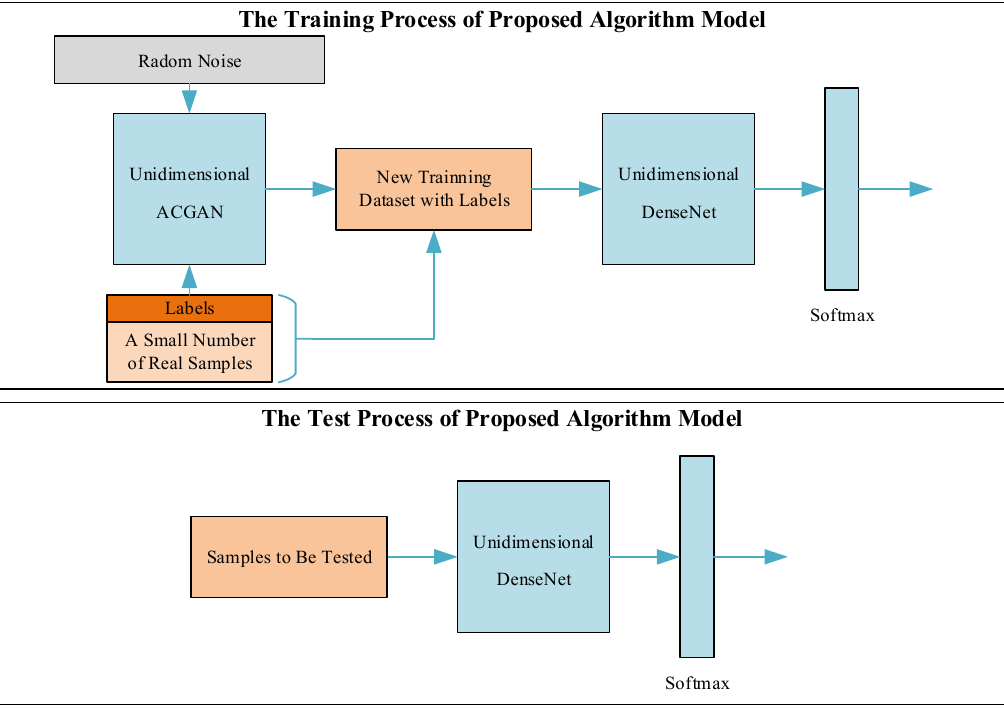
Figure 2. The framework of a short-wave radio station’s LE behavior recognition algorithm.